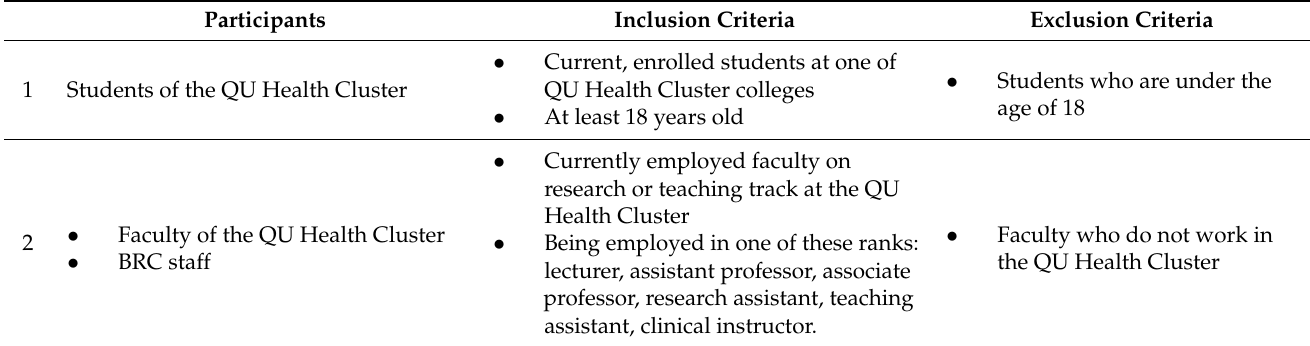
Figure 1. Flowchart for the screening of participants. Table 1. Inclusion and Exclusion Criteria .